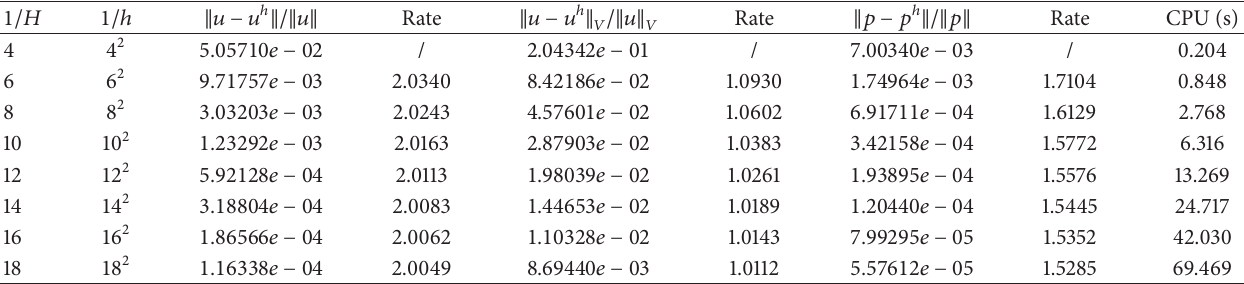
Table 4: Convergence of two-level Newton iteration